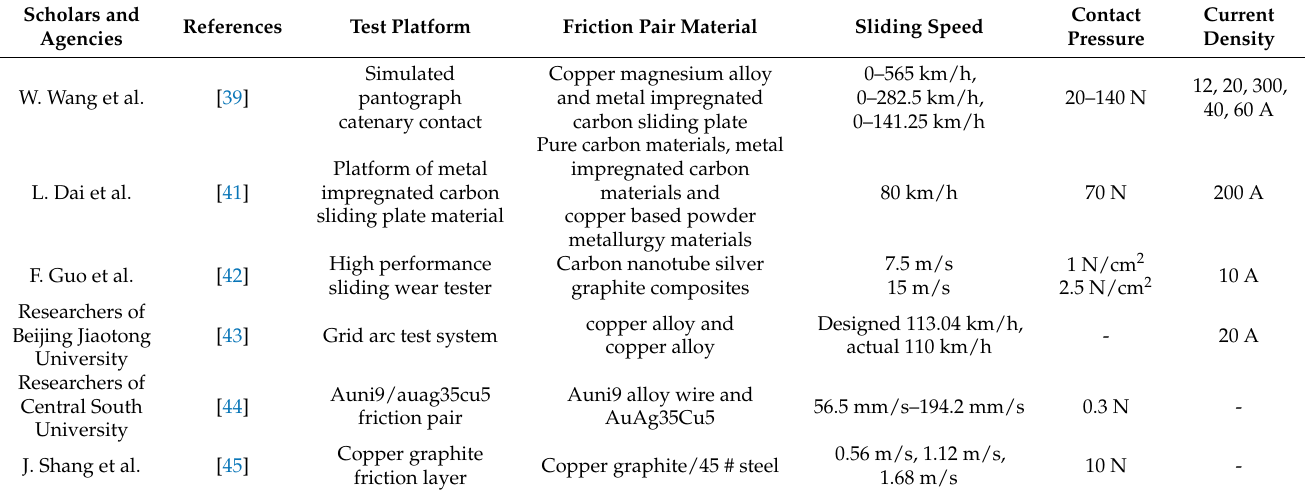
Table 2. The sliding speed-related